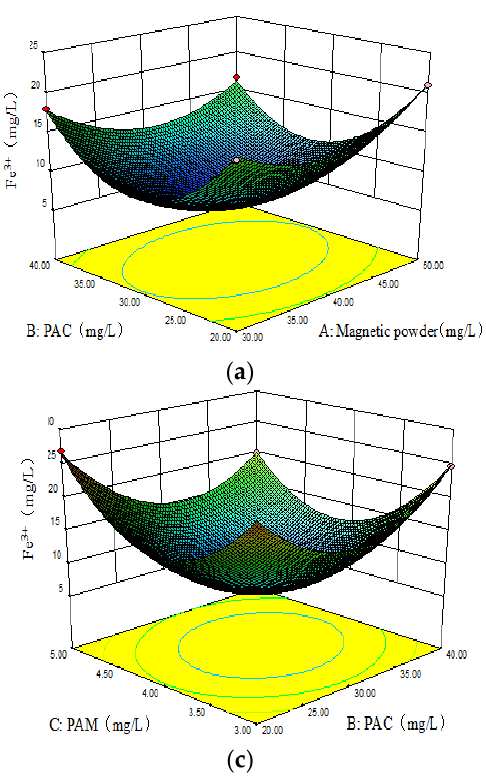
Figure 4. Response surface diagram of interaction among various factors (Fe 3+ ) ( a ) magnetic powder and PAC ( b ) magnetic powder and PAM ( c ) PAC and PAM.